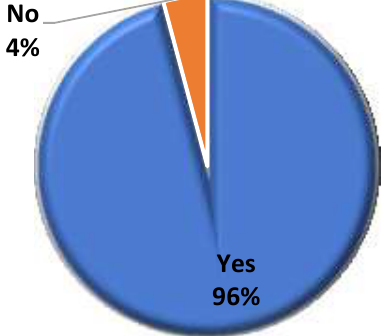
Figure 3. Safety on the Nature Resource (Source: Research data, 2019)